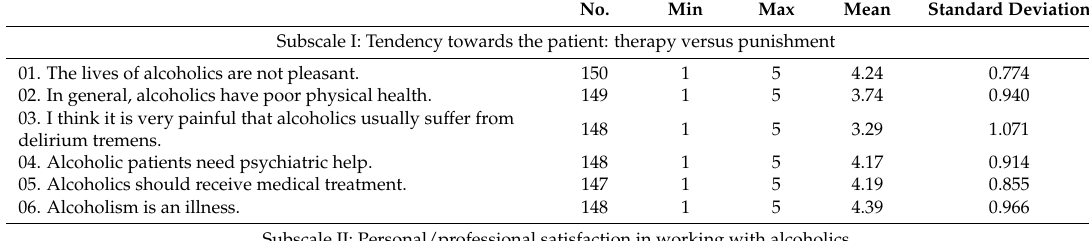
Table 3. Disaggregated descriptive statistics per response in the Seaman–Mannello scale. No. Min Max Mean Standard Deviation Subscale I: Tendency towards the patient: therapy versus